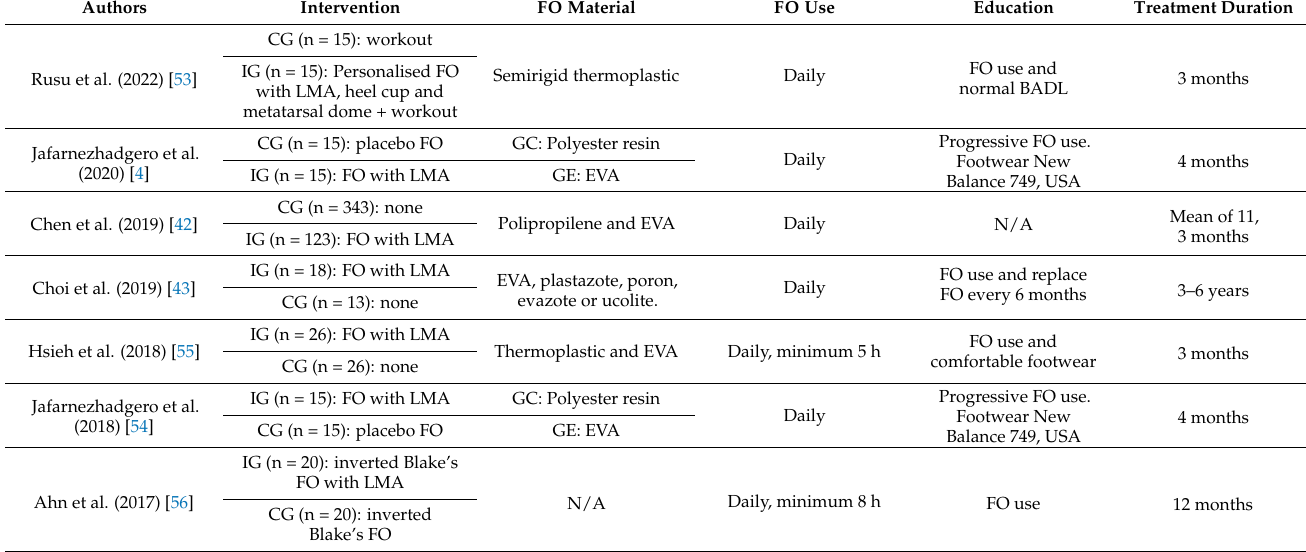
Table 3. Intervention